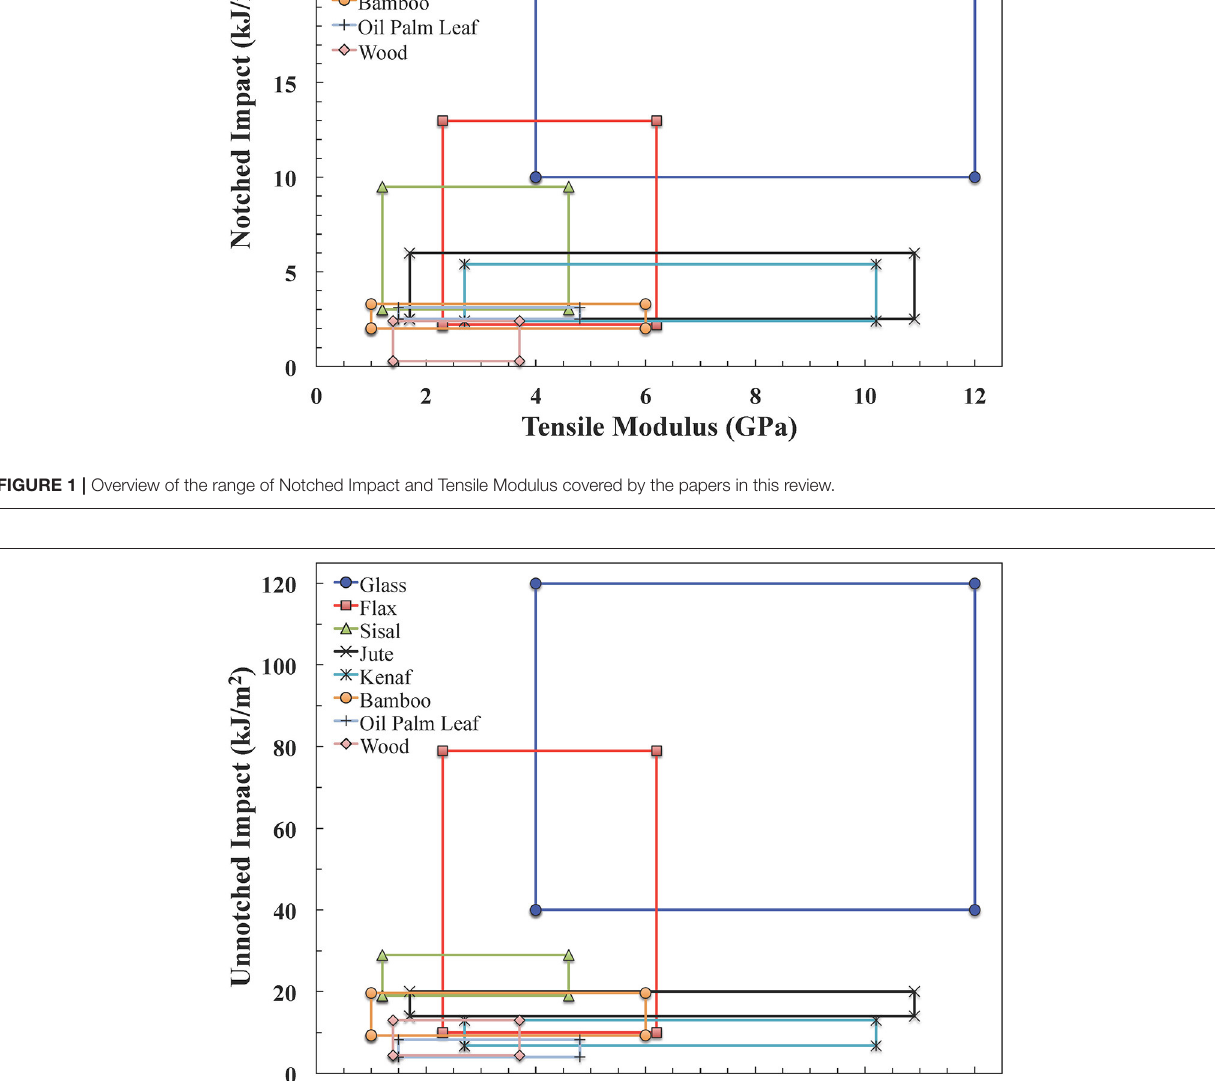
Frontiers in Materials |